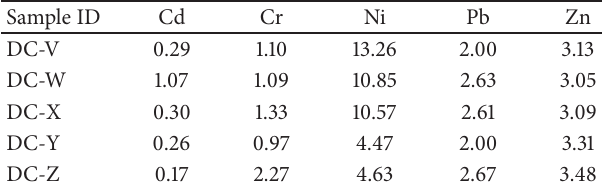
Table 5: Soil-to-plant transfer factors of studied trace metals. Sample ID